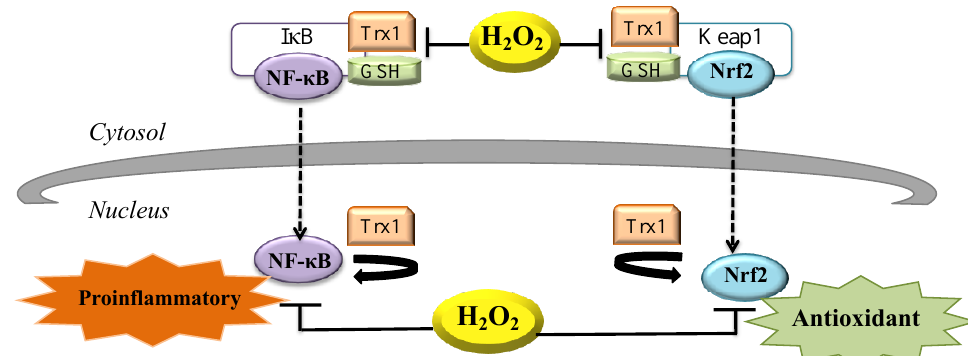
Figure 3. Proinflammatory and antioxidant signaling via H 2 O 2 . Release of inhibitory subunit (IκB) of NF-κB is due to oxidation by cytosolic H 2 O 2 that leads to dissociation of the NF-κB/IκB complex. Once in the nucleus, NF-κB activity is favored by nuclear thioredoxin-1 (Trx1) and can repair oxidatively damaged proteins. NF-κB activity is inhibited by increased nuclear H 2 O 2 production. During oxidative stress the presence of H 2 O 2 leads to the dissociation of the Nrf2/Keap1 complex and cysteinyl residues of Keap1 are modified. Nrf2 translocates into the nucleus to induce expression of its target genes that triggers antioxidant signaling [59].